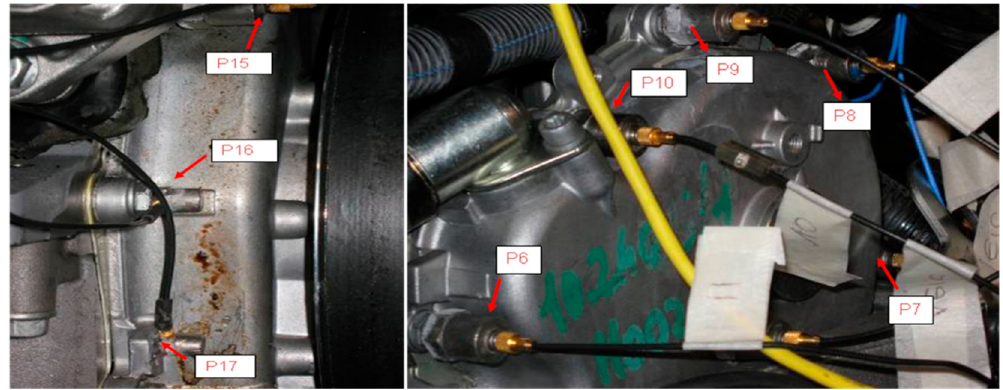
Figure 3. Accelerometers placed in proximity to the connecting pins between the chain cover and the rest of the engine.